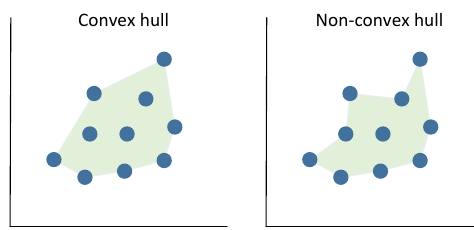
Figure 5. Difference between convex and non-convex hull.